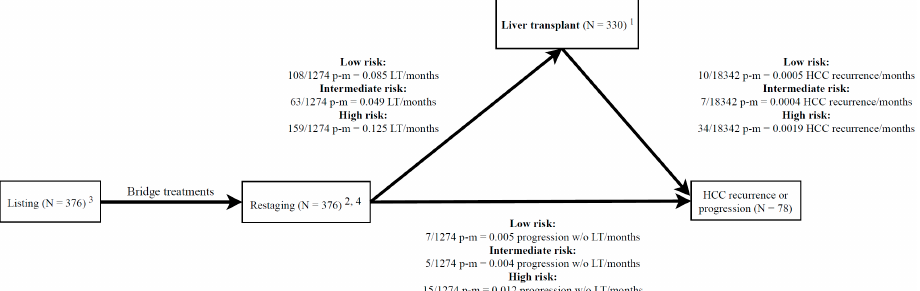
Figure 1. Management of patients with hepatocellular carcinoma (HCC) from listing to HCC relapse